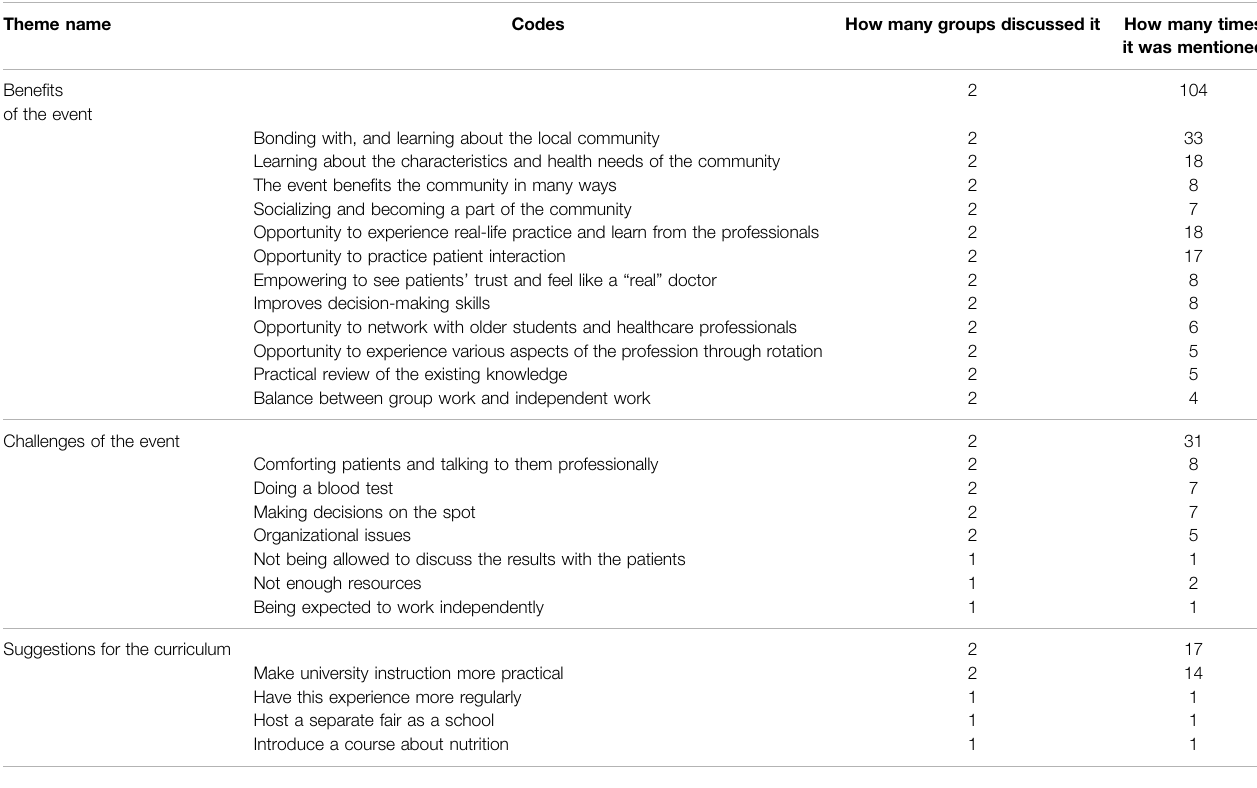
TABLE 5 | Focus group thematic framework.